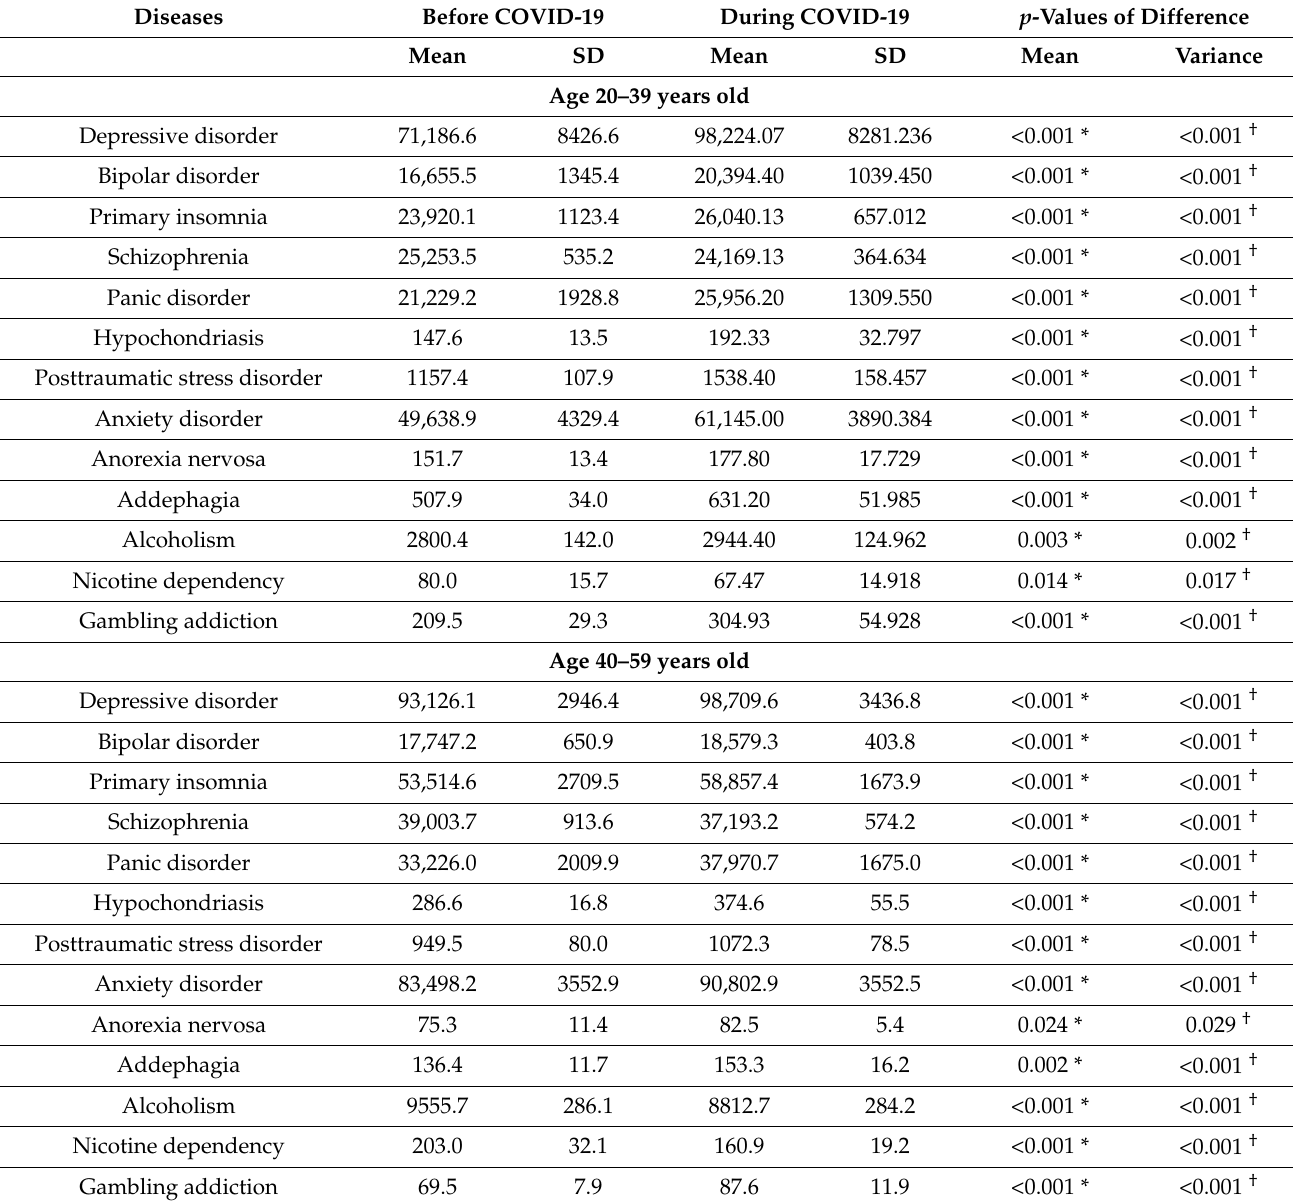
Table 3. Mean, standard deviation of incidence of diseases before and during COVID-19, and their difference in the subgroup by